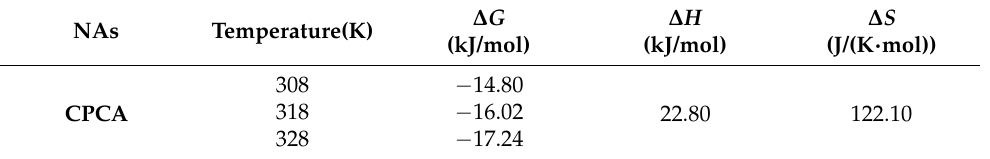
Table 4. Thermodynamic parameters of CPCA adsorption on PS − DEA − 5.